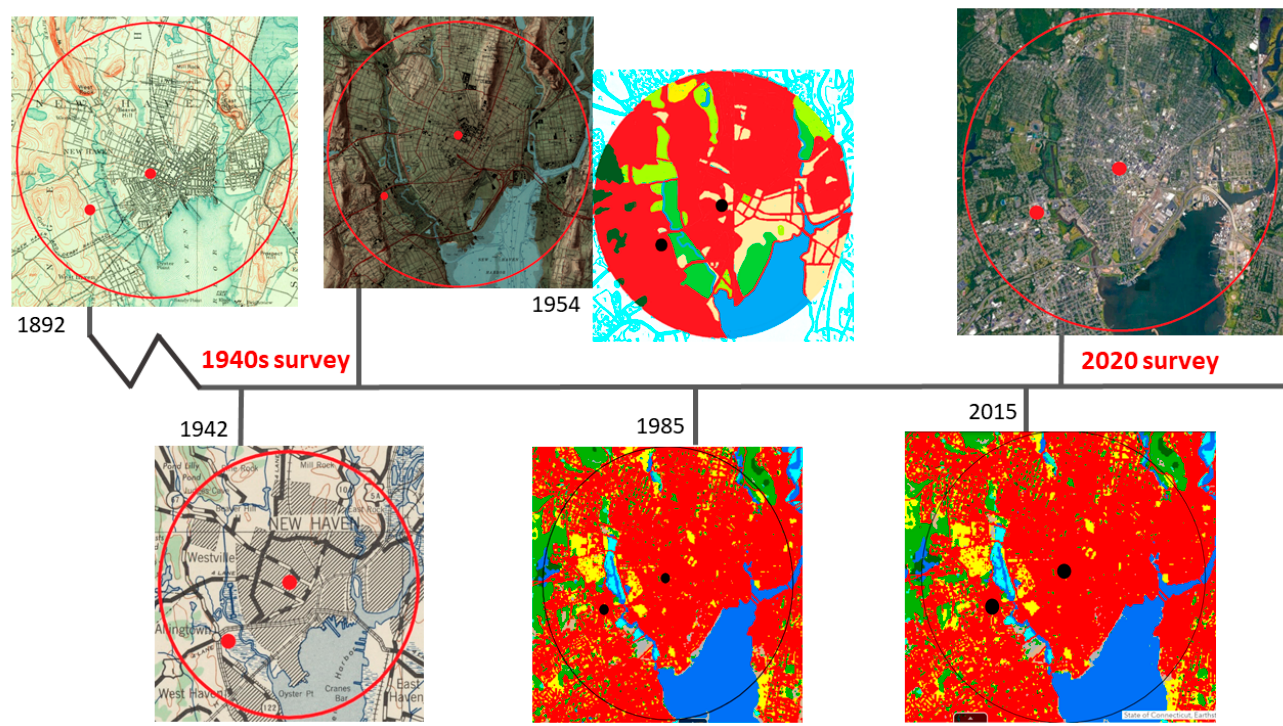
Figure 4. Topography and land cover of New Haven, CT, from 1892–2015. Source: 1892 [51]; 1942 [52]; 1954 [53]; 1954 land cover [47]; 1985 and 2015 land cover [50]; 2020 [54].